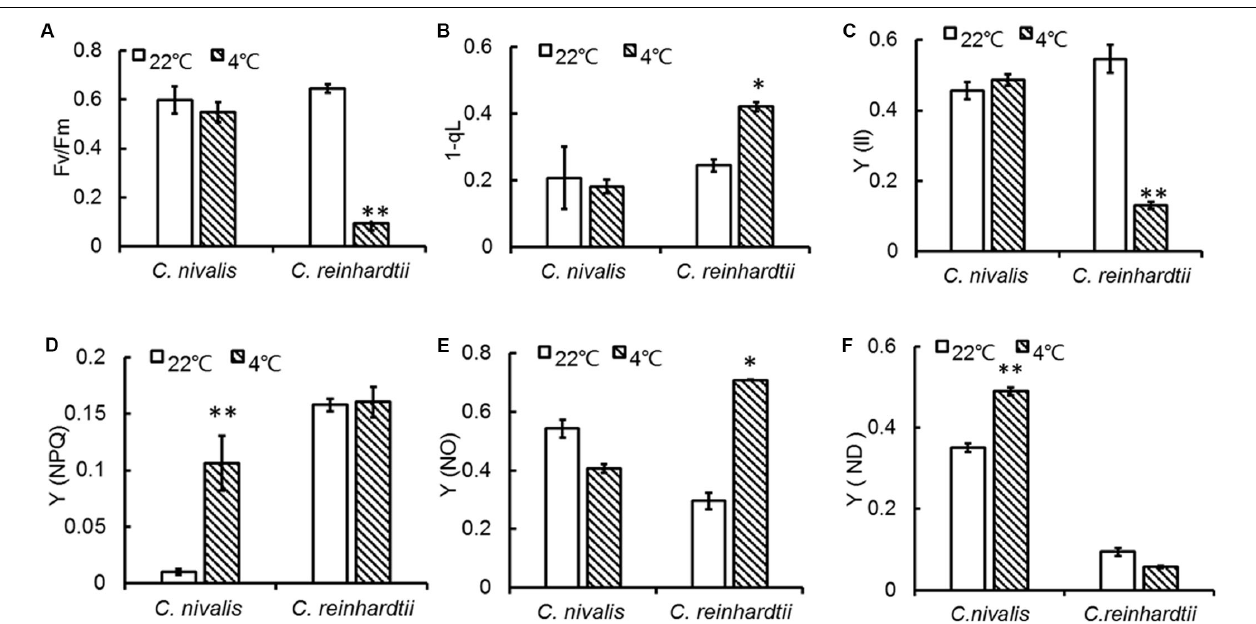
FIGURE 2 | PSII changes in C. nivalis and C. reinhardtii at low temperatures. (A) Fv/Fm, the maximum quantum yield of PSII photochemistry. (B) 1-qL, the proportion of closed PSII centers. (C) Y (II), the effective photochemical quantum yield of PSII. (D) Y (NPQ), regulated energy dissipation. (E) Y (NO), non-regulated energy dissipation. (F) Y (ND), non-photochemical energy dissipation due to donor-side limitation. The significance of the differences between 22 and 4 ◦ C in the same strain in the current and following figures were tested using a one-way ANOVA. * p < 0.05, ** p <